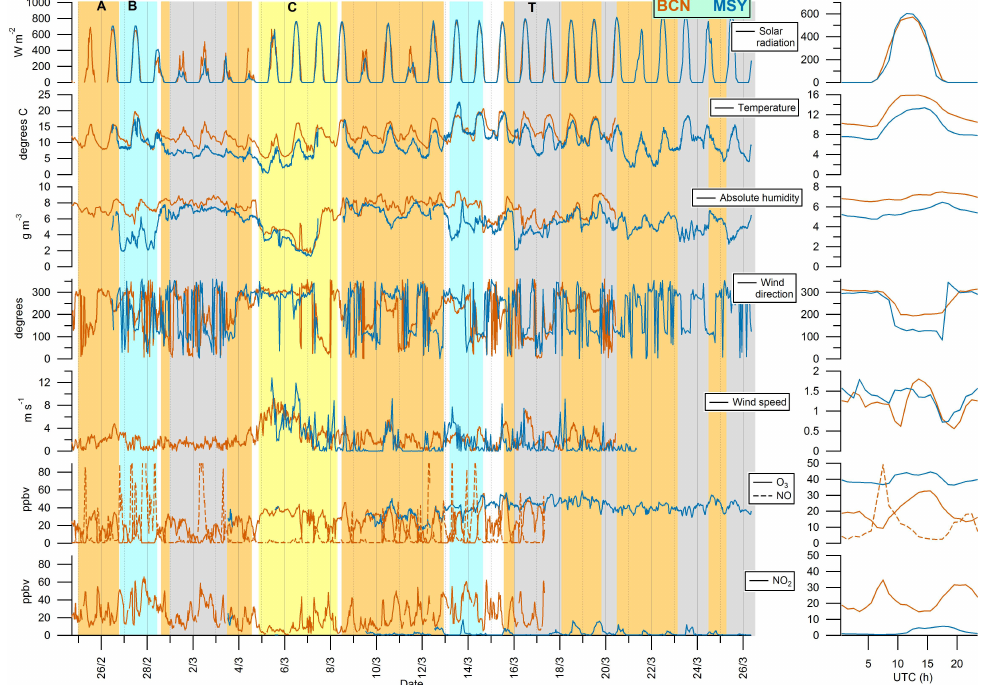
Fig. 2. Left panels: Time series of meteorological parameters (solar radiation, temperature, absolute humidity, wind direction and speed) and of inorganic gaseous pollutants (O 3 , NO 2 and NO) measured at BCN (vermillion traces) and MSY (blue traces). Background colors correspond to the atmospheric scenarios described in Sect. 2.4: A (orange), B (light blue), C (yellow) and T (grey). Date labels indicate 00:00UTC. Right panels: Hourly averaged diurnal cycles of the entire time series. Please note that, for clarity, NO for MSY is not displayed because its values were usually below the limit of detection (1µgm − 3 , 0.8ppbv).